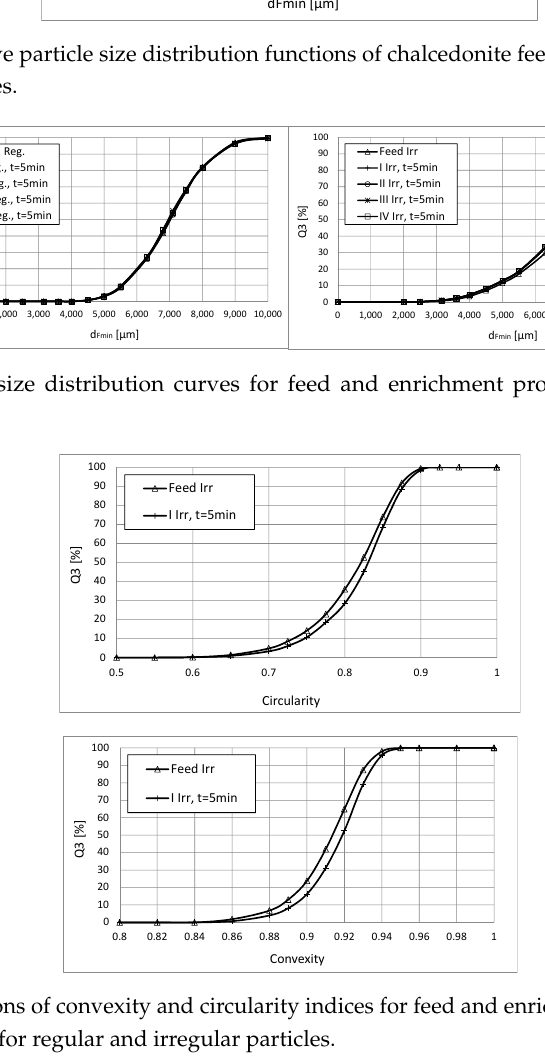
Figure 14. Distributions of convexity and circularity indices for feed and enrichment products of I and IV layer—separately for regular and irregular particles.